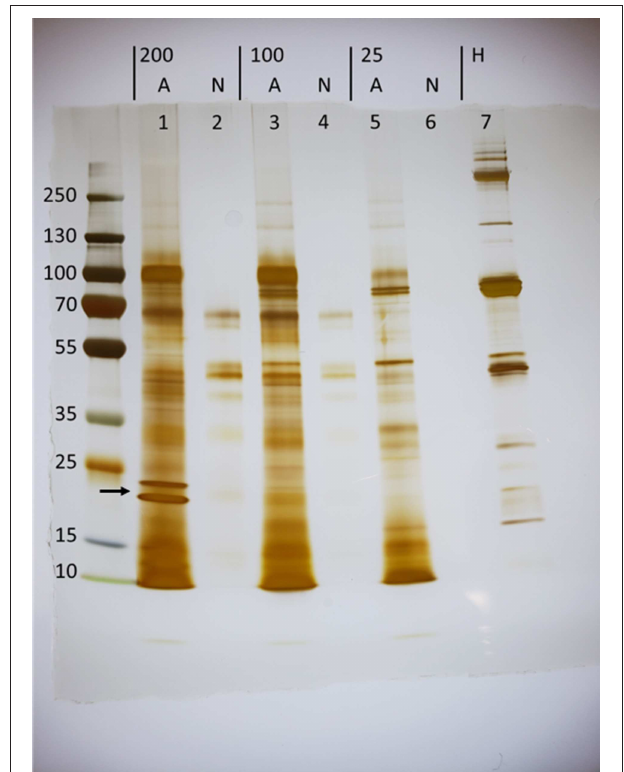
FIGURE 1 | Exposure of Heterorhabditis bacteriophora infective juveniles (IJs) to host hemolymph induces the secretion of unique proteins (arrow). Concentrated ES products were loaded for groups of 200,000 (200), 100,000 (100), and 25,000 (25) nematodes that were either activated (A) in Manduca sexta hemolymph or left non-activated (N) in Ringer’s buffer. Activation took place over a period of 20h, at which point IJs were washed, transferred to fresh ringers, and incubated for 5h to collect ES products. Lanes 1,3, and 7 carry 6 µ g of protein while all others were loaded with a maximum volume, as protein could not be detected using the BCA